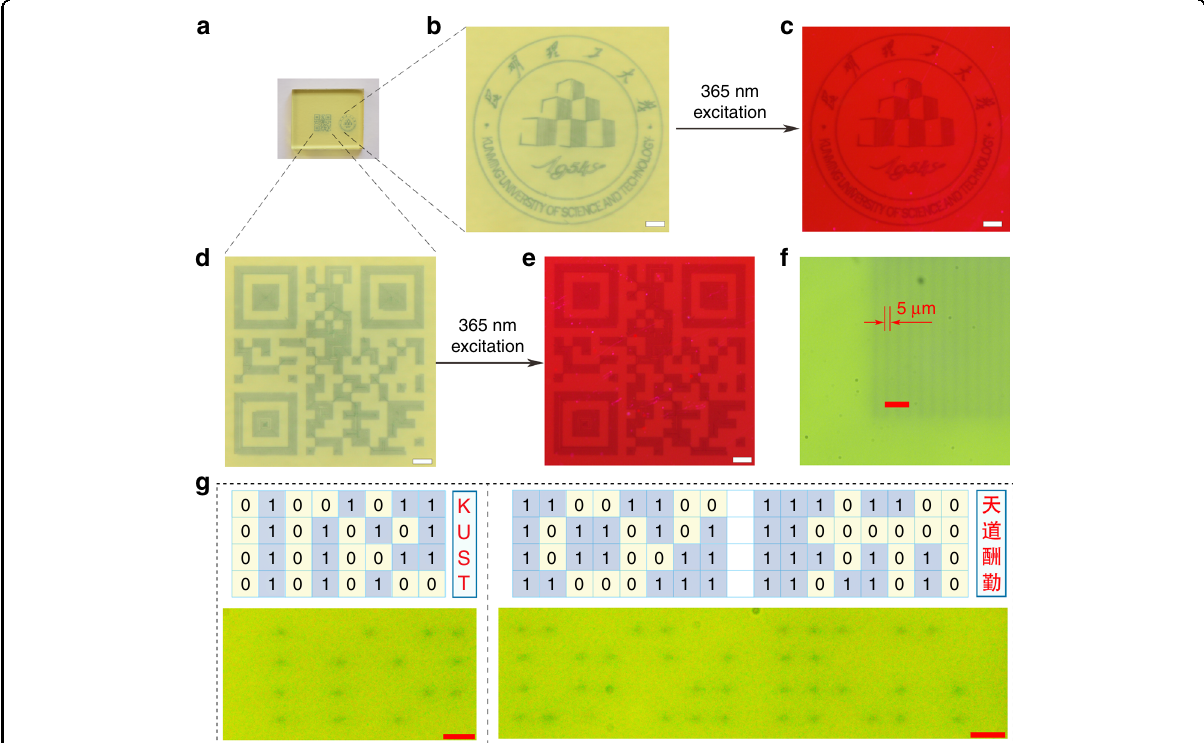
Fig. 4 Optical information writing and readout. a , b , d The raw ( a ) and enlarged ( b , d ) photochromic logo patterns. c , e The enlarged luminescent logo pattern upon the 365 nm excitation. d , e The information data were hidden into the photochromic ( d ) or luminescent ( e ) two-dimensional code pattern, and the information “ I love KUST ” can be obtained by scanning the two-dimensional code pattern. Scale bar: 500 μ m. f The scanning line width of focused 473 lasers. Scale bar: 40 μ m. g The “ KUST ” alphabet (left) and the “ tian dao chou qin ” idiom (right) recorded into the transparent glass by binary format. Scale bar: 20 μ